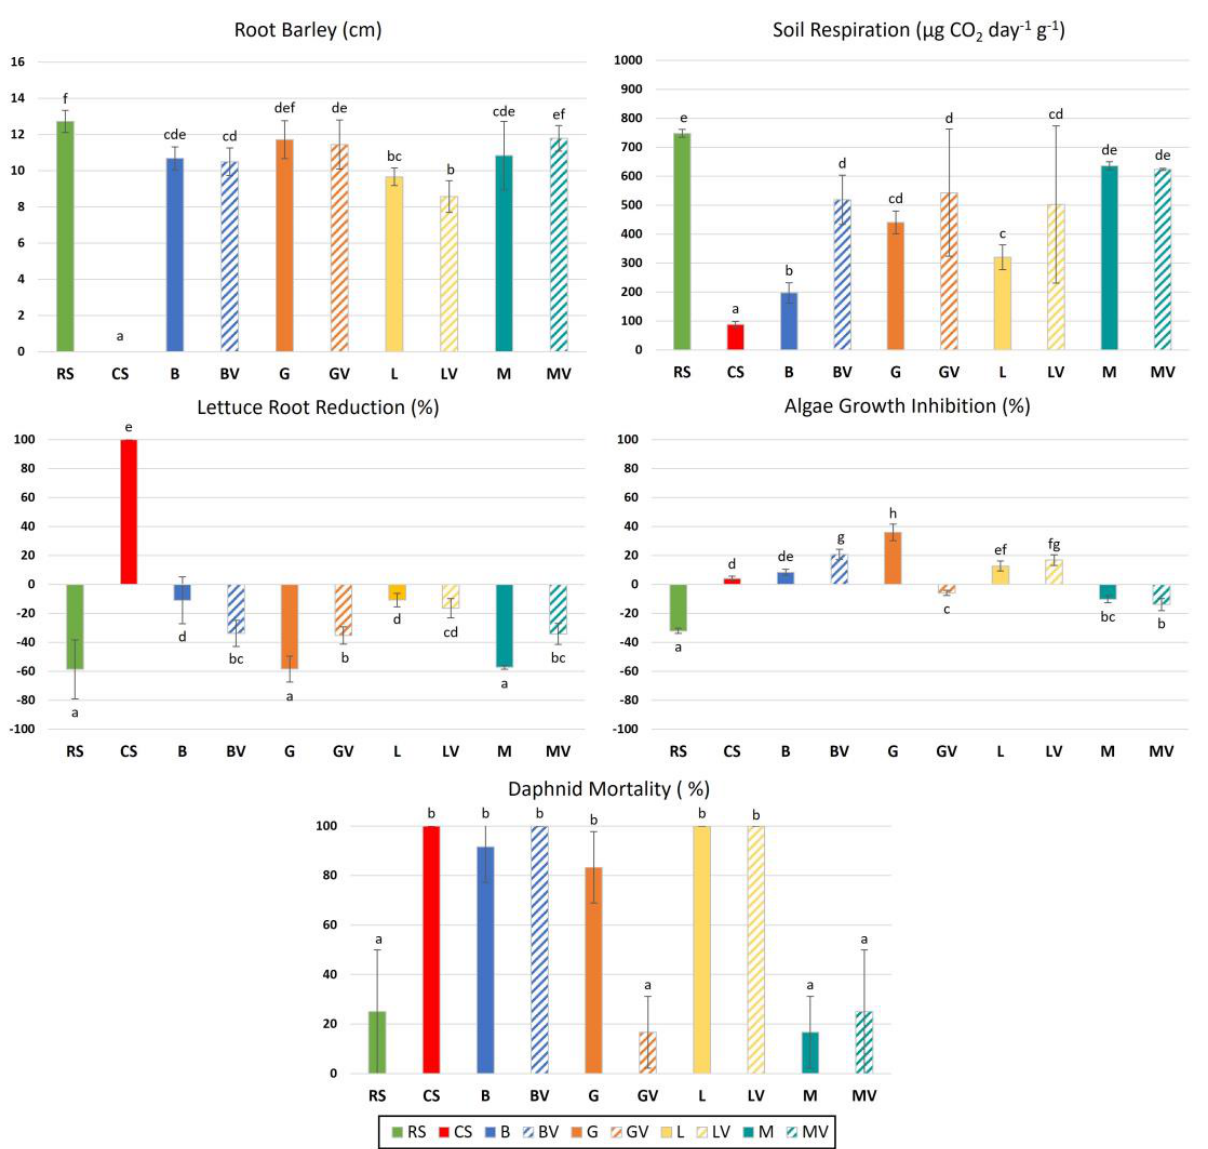
Figure 2. Ecotoxicological tests carried out in: a, soil-solid fraction: root barley elongation (cm) and soil induced respiration (μg CO 2 day −1 g −1 soil) and b, in soil-water fraction: lettuce root reduction (%), algae inhibition growth (%) and daphnid mortality (%). Block bars represent the recovered soil (RS), the control polluted soil (CS); and the different studied amendments (B: Biopiles, G: Gypsum, L: Landfarming, M: Marble sludge). Striped bars indicate the use of composite amendments, with the addition of vermicompost (BV, GV, LV and MV). Lowercase letters indicate significant differences among treatments according to Duncan post hoc test ( p < 0.05).